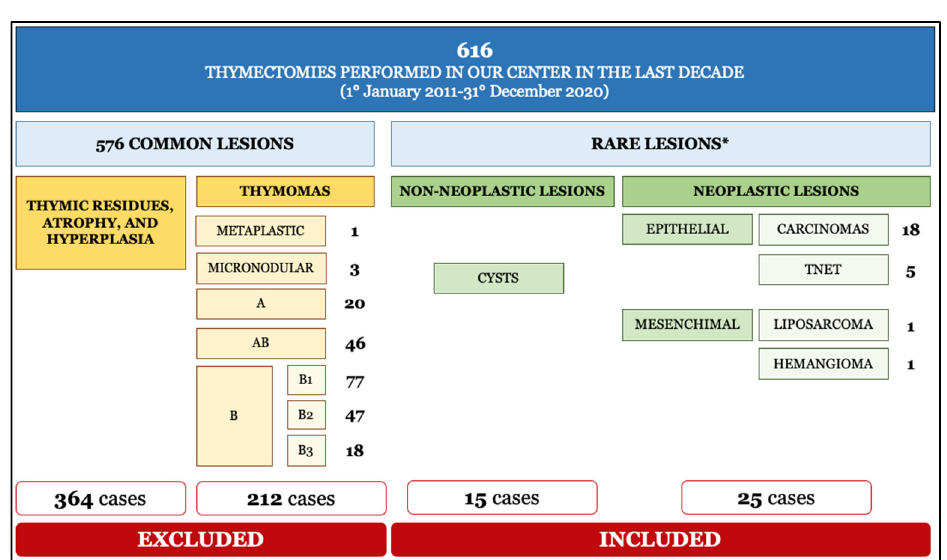
Figure 1. Histopathological classification of thymectomies performed at the Padova University Hospital in the last decade. * Lesions of concern in the present study. Abbreviations. TNET: thymic neuroendocrine tumors.